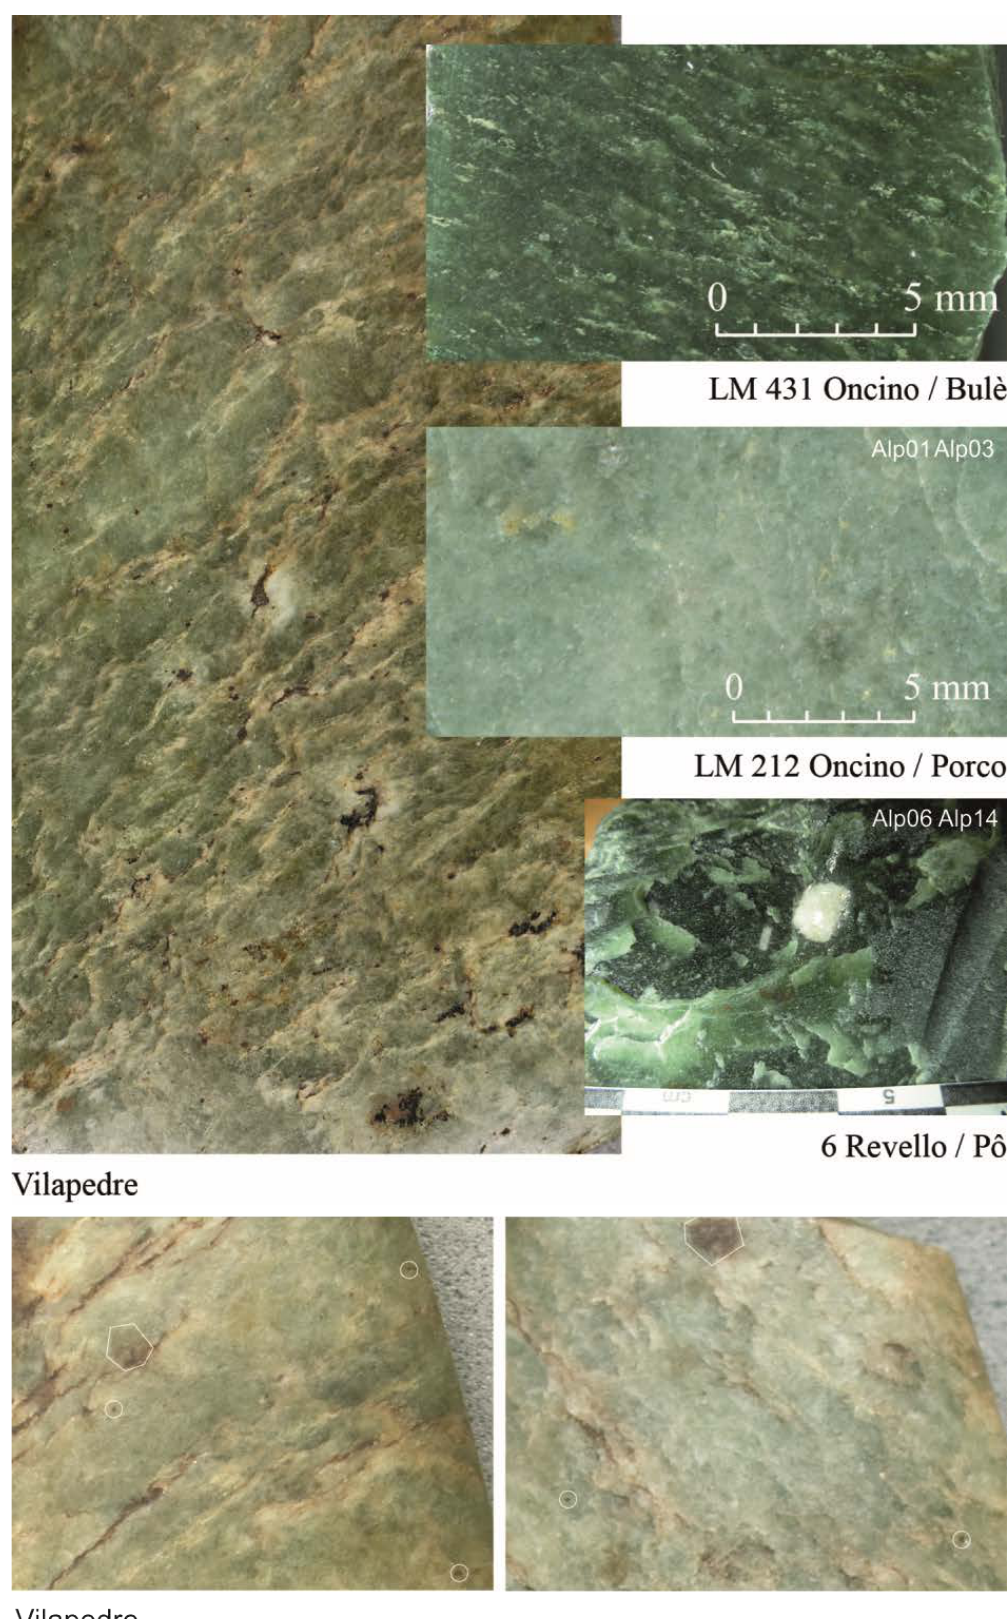
Figure 5. Macroscopic detail of the Vilapedre axe and of several Alpine geological samples. White hexagons: deformed garnets. White circles: hollow-core small garnets. Vilapedre images are shown at different scales. Photos P. Pétrequin and O.